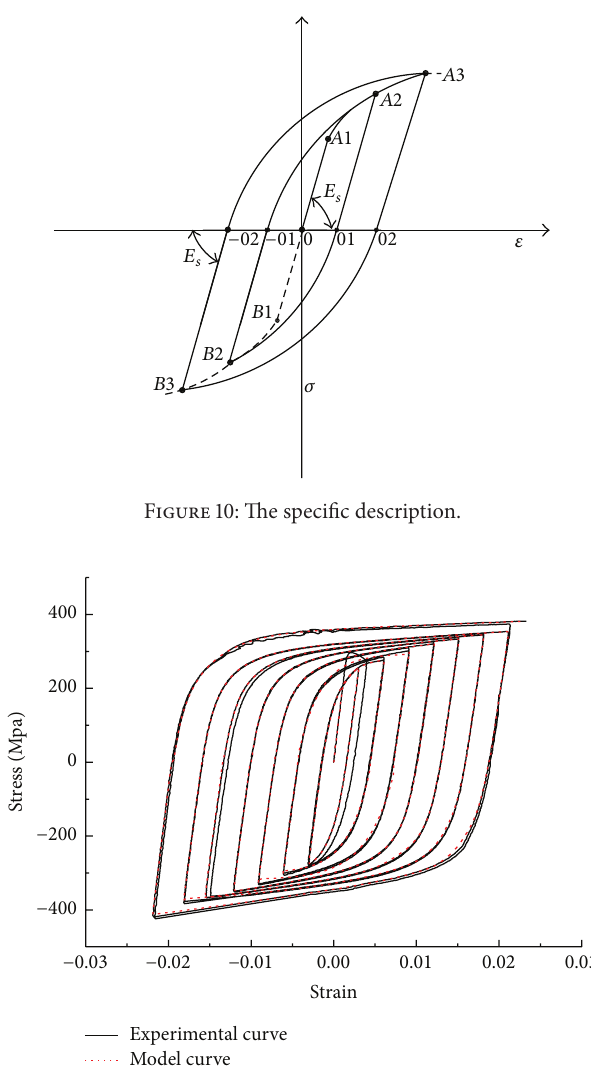
Figure 11: Comparison chart between model of the hysteresis criterion and experimental data of